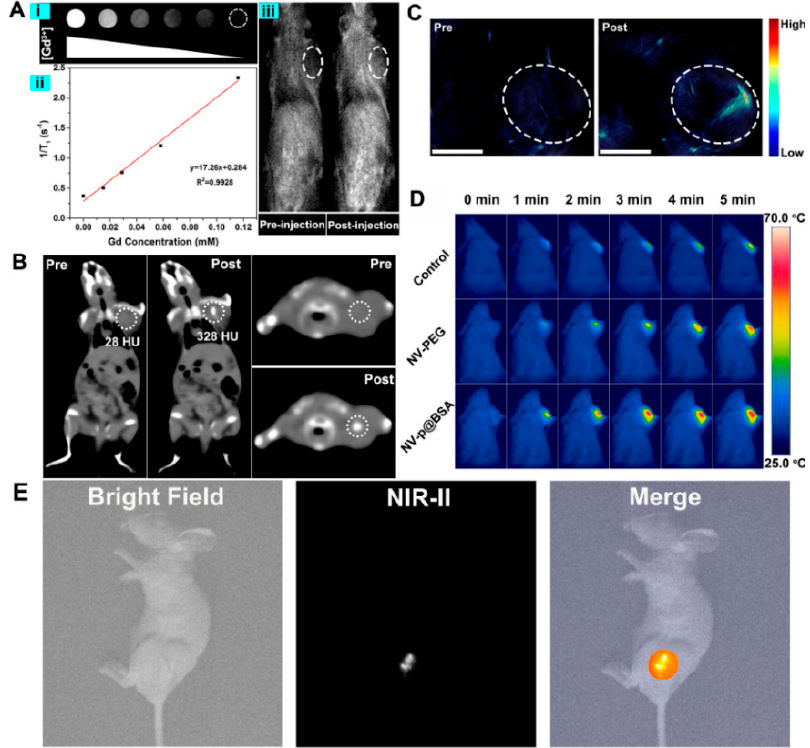
Figure 4. ( A ) Representative T 1 -weighed MR contrast effects of NV-p@BSA NPs at different concentrations (i); graphs of relaxation rates R 1 versus different concentrations of NPs (ii); in vivo MR images of tumor-bearing mice before and after injection of NV-p@BSA NPs (iii). ( B ) In vivo CT images of tumor-bearing mice before and after injection of NV-p@BSA NPs. The white circles indicate the tumor regions. ( C ) Representative PA images at the tumor region before and after injection of NV-p@BSA NPs. Representative thermal images ( D ) and NIR-II fluorescence images ( E ) of mice subjected to 808 nm laser irradiation (1.0 W cm − 2 ).